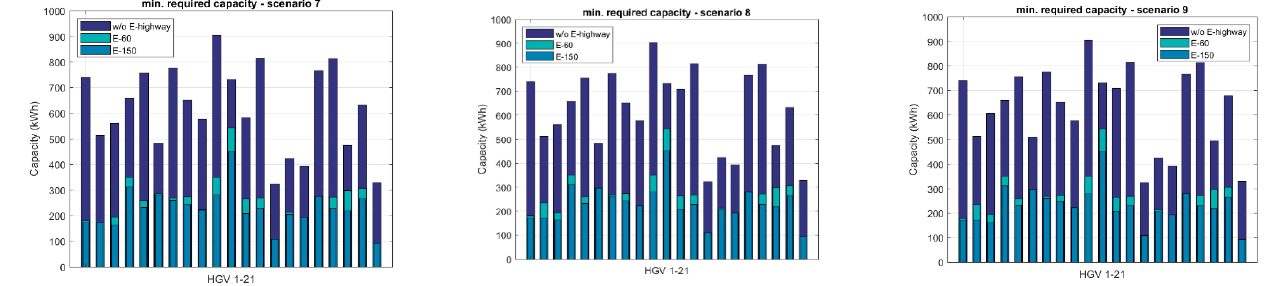
10 of 17 Figure 6. Required minimum capacity — 150 kW charging stations — scenarios 4 – 6 (own illustra- tion).